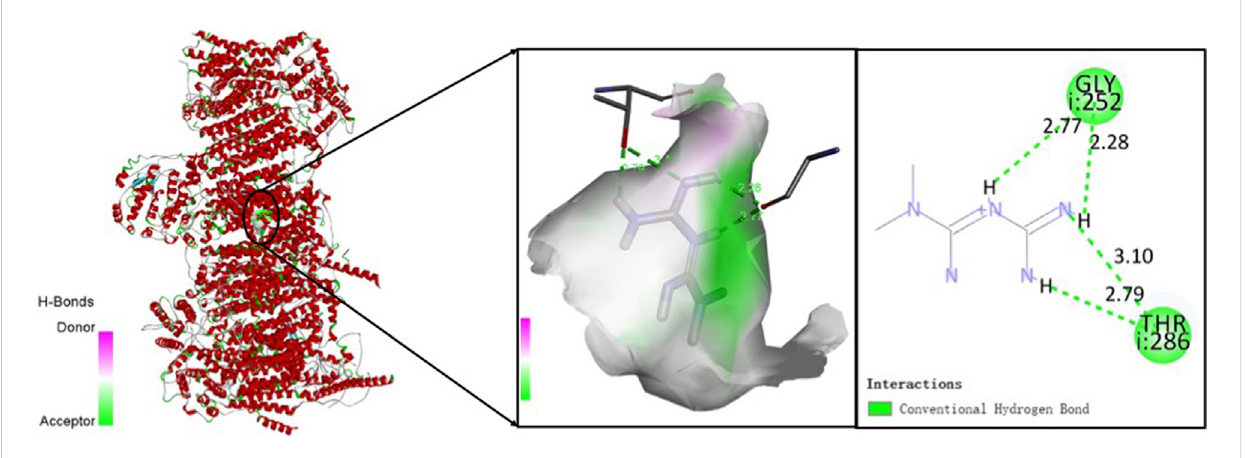
FIGURE 9 The two-dimensional molecular docking diagram of metformin and target protein NDUFC1. Hydrogen bonds are shown as green lines, and hydrophobic forces are denoted as pink